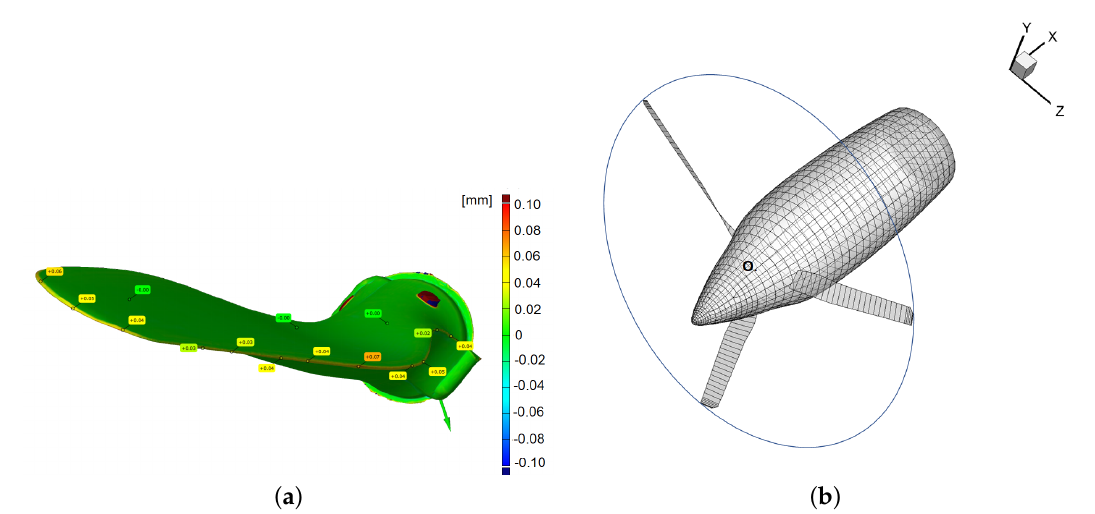
Figure 3. ( a ) Geometry of the Varioprop 12C propeller blade; the coloured bar indicates the error in mm between the reconstructed CAD geometry and the surfaces provided by the three-dimensional (3D) scanner. ( b ) Layout of propeller numerical model and reference